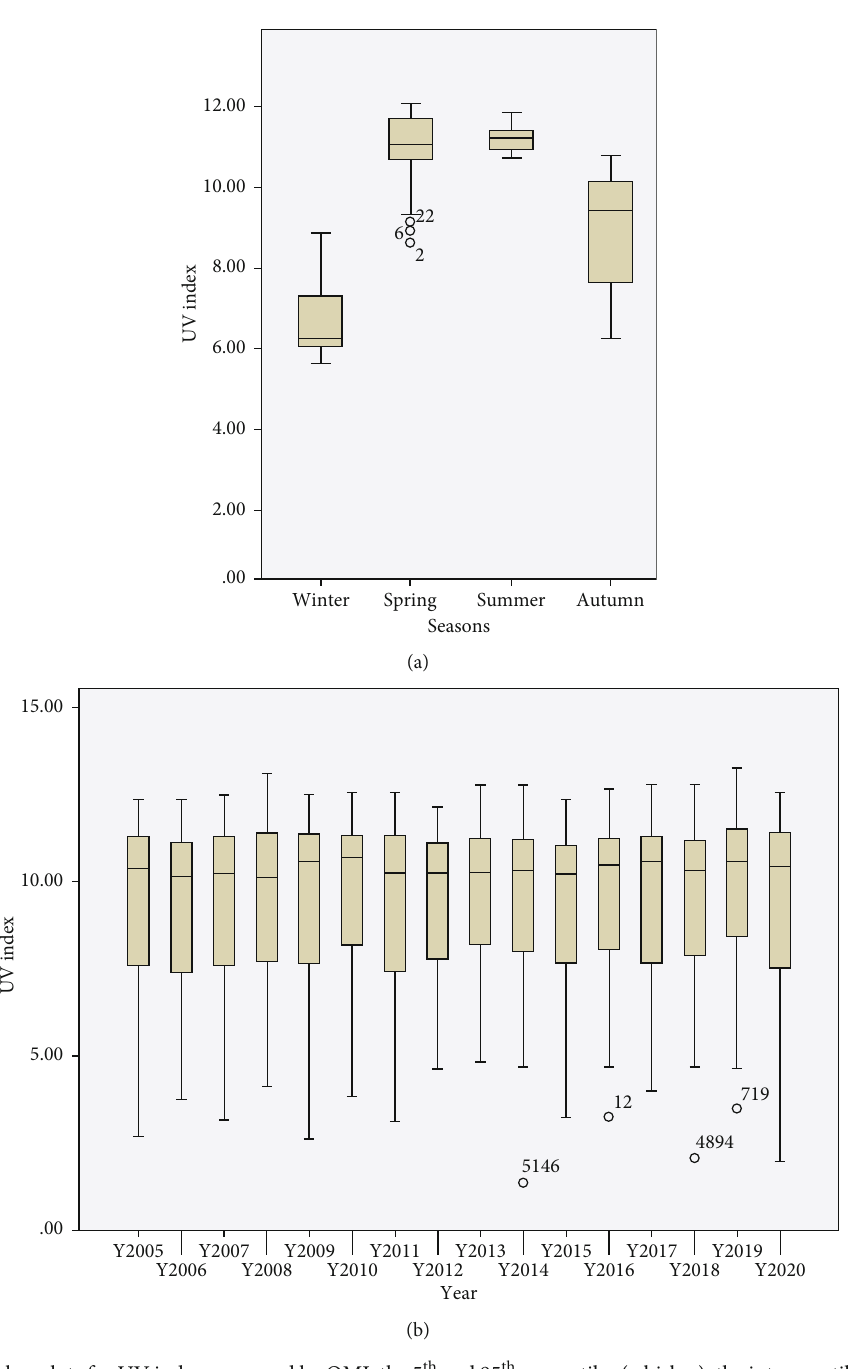
Figure 8: The box-whisker plots for UV index measured by OMI, the 5 th and 95 th percentiles (whisker), the interquartile range (box), and the mean value (dash in the Box Medill): (a) indicates for each season statistics, and (b) indicates for each year statistics on the campus of KAU during the study